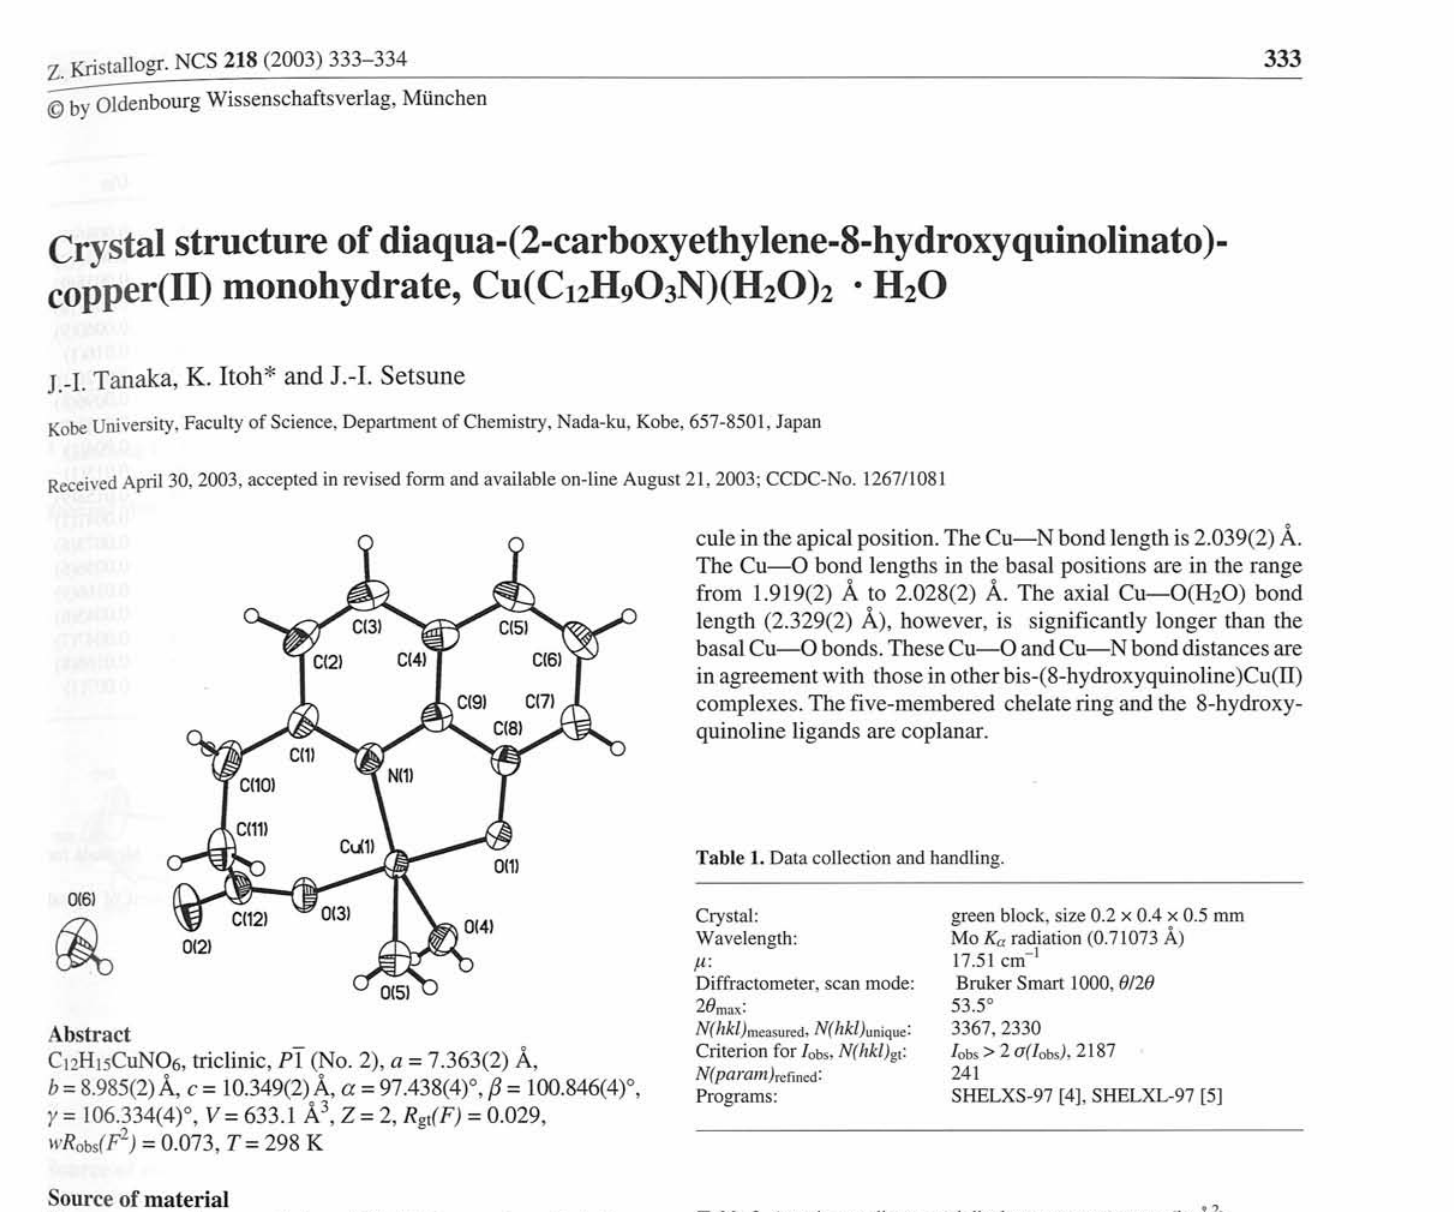
Table 2. Atomic coordinates and displacement parameters (in